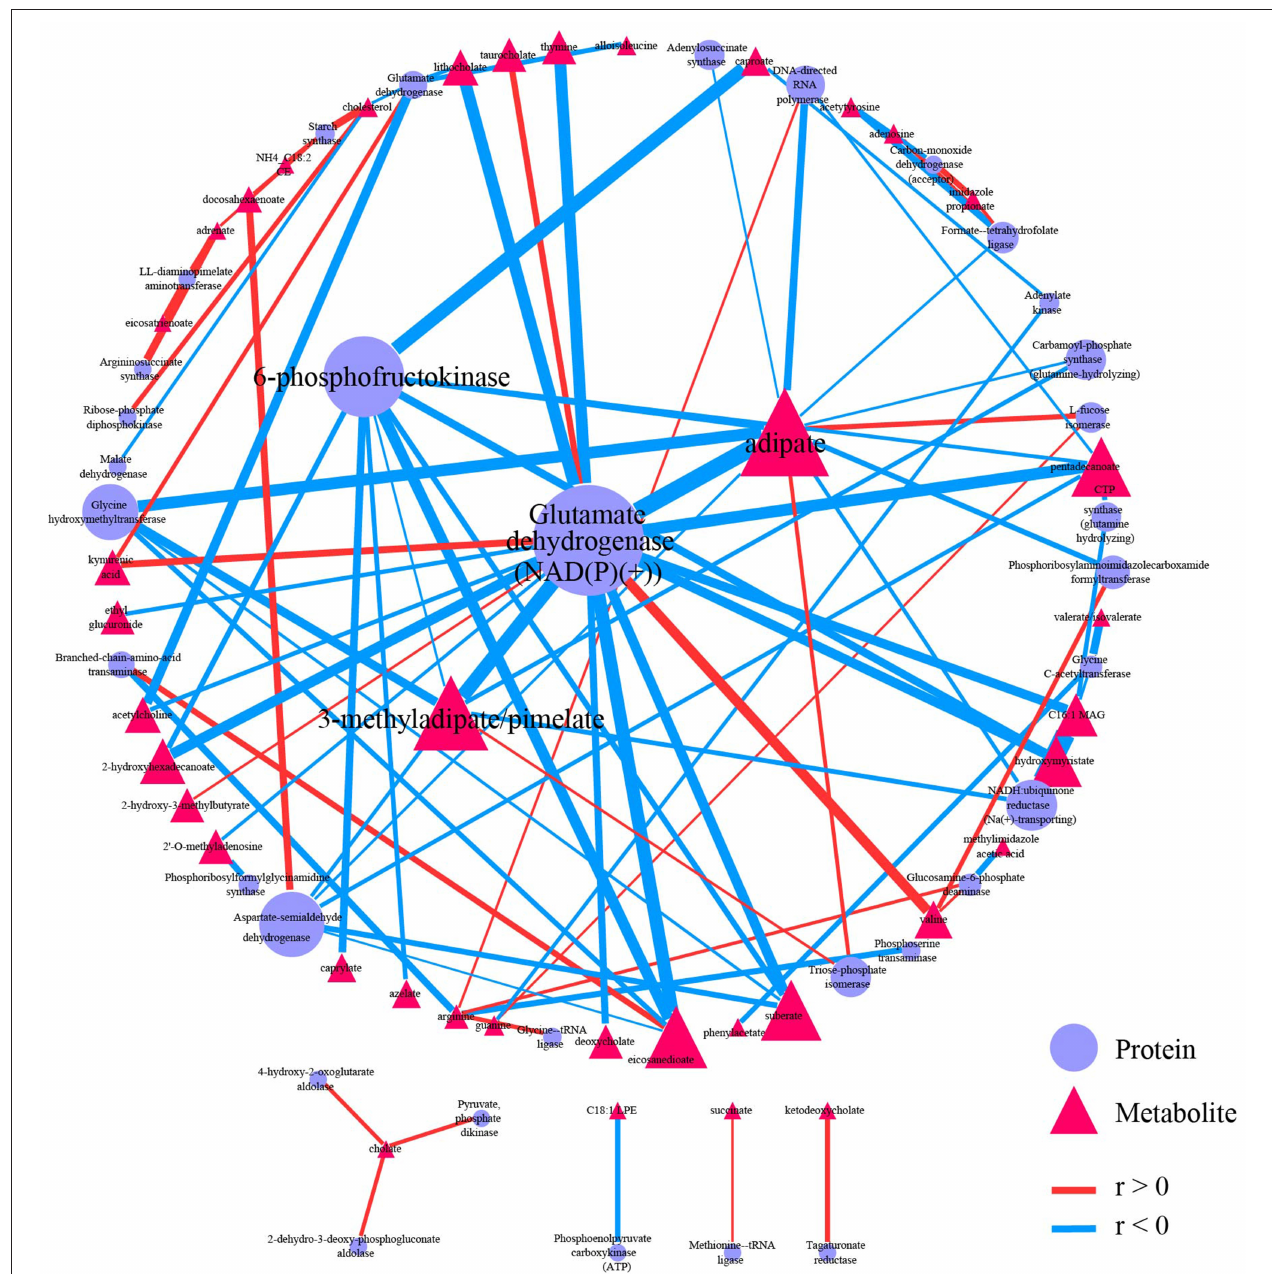
FIGURE 5 | Correlation-based network. Network showed 95 qualified (| r | > 0.3 and FDR < 0.05) correlation. Nodes were colored and shaped by variables type (metabolite or protein). Nodes size depends on the evcent centralities of the variables. Edges were colored by the sign of r, and edges’ width depends on | r |. A primary network plot was generated in iMAP, and the layout of nodes was modified in Cytoscape 3.8.0. A circular layout was applied, and the four biggest nodes were placed in the center